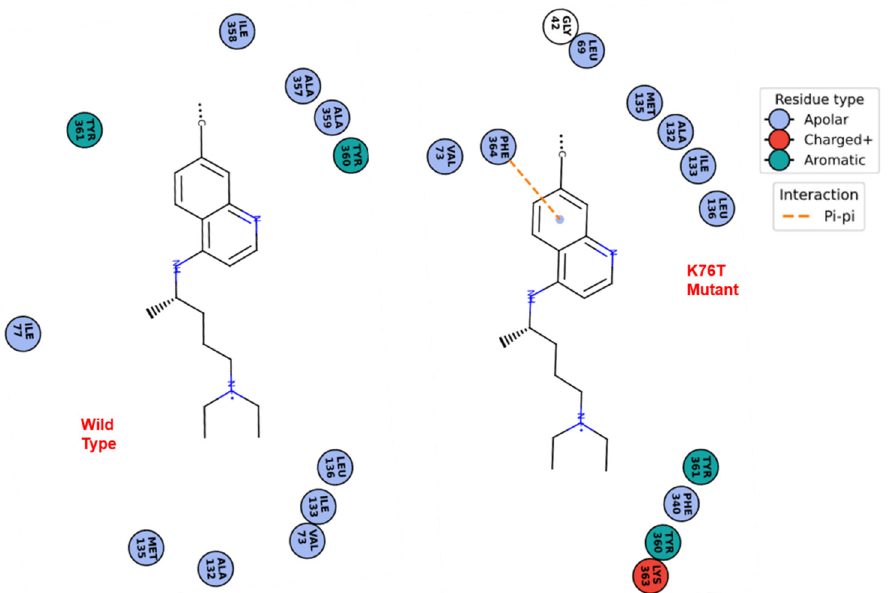
Figure 5. Interaction and contact maps of the CQ ligand bound to the wild type ( left ) and Lys76Thr mutant ( right ) receptors.